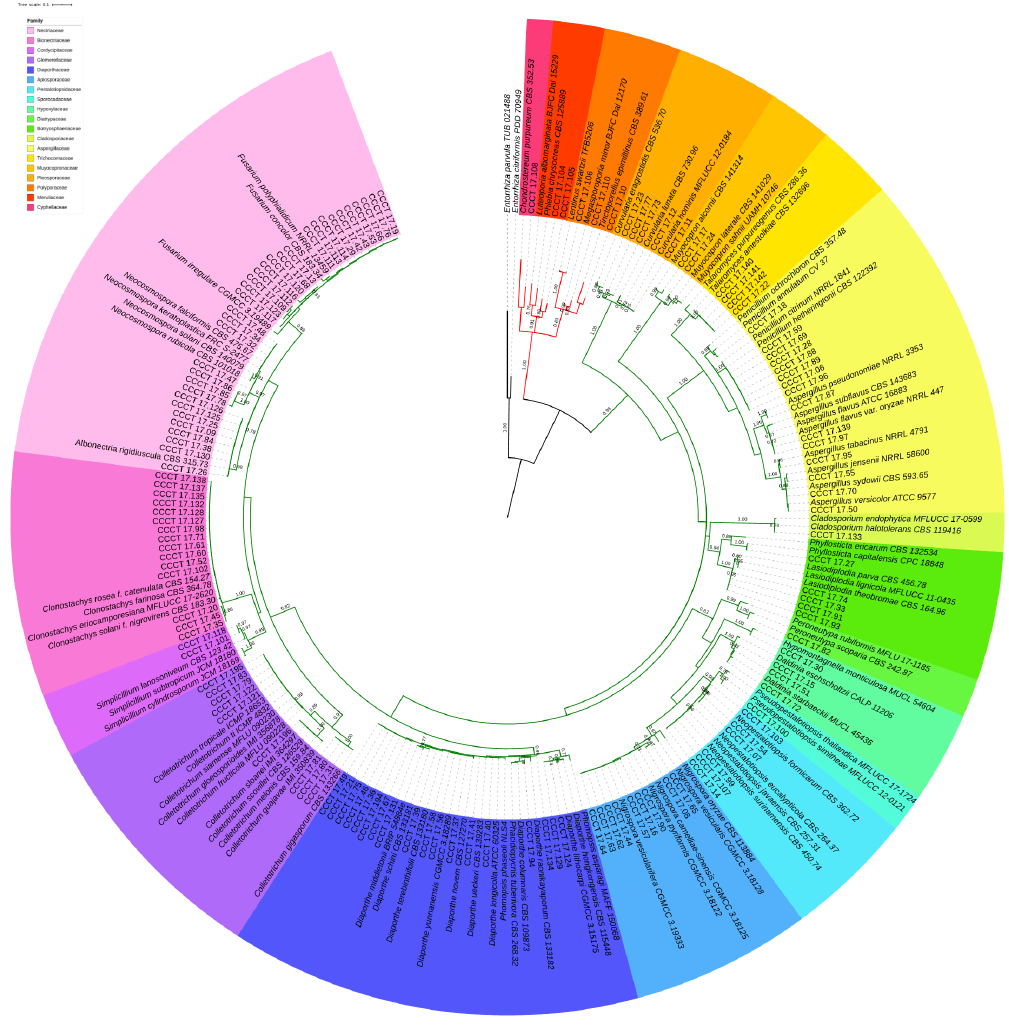
Figure 1. Phylogenetic tree for ITS sequence data of the 136 strains isolated from guarana with other species detailed in Table S1. Entorrhiza parvula TUB 021488 T and E. citriformis PDD 70949 T were used as outgroup. The clade highlighted by red branches is composed by Basidiomycota species. The clade highlighted by green branches is composed by Ascomycota species. Selected model: K2+G+I. The percentage of trees in which the associated taxa clusters together in the bootstrap test (1,000 replicates) is shown above the branches. The tree is drawn to scale with branch lengths measured in the number of substitutions per site. All positions with less than 95% site coverage were eliminated. There were a total of 282 positions in the final dataset.